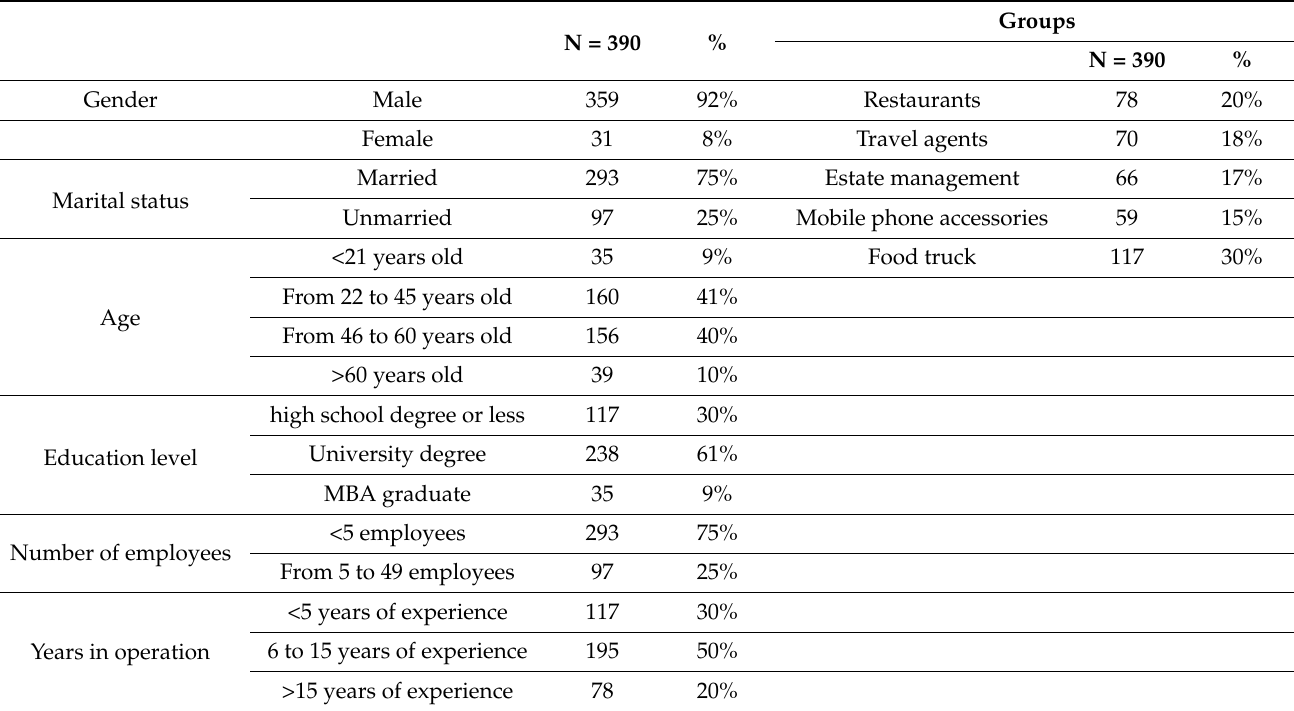
Table 2. Entrepreneurs profile.